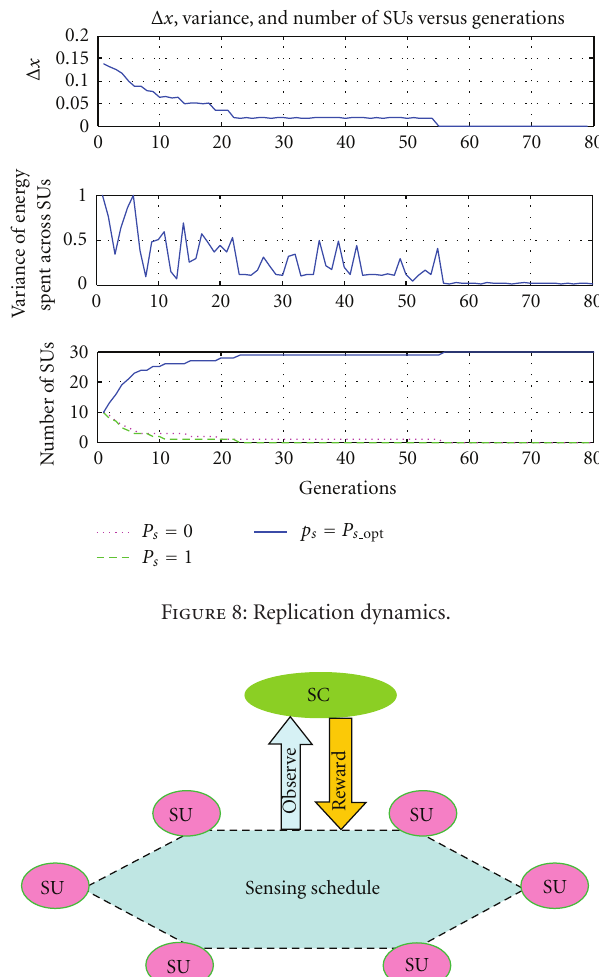
Figure 9: Reward allocation based on the sensing